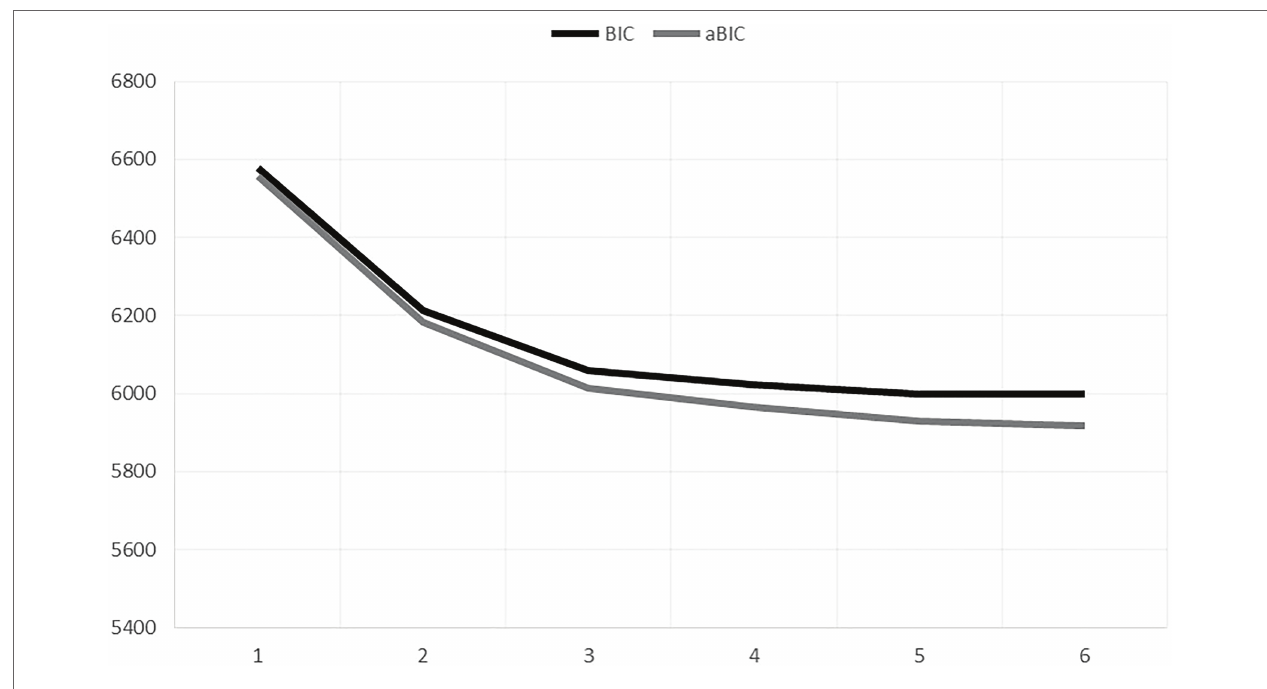
FIGURE 1 | Elbow plot of information criteria for different profile solutions.